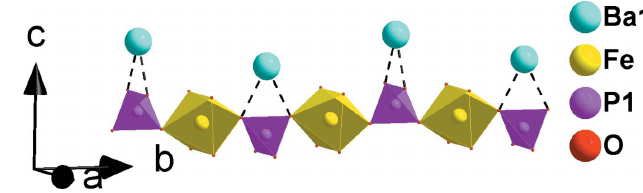
Figure 3 A chain formed by sharing corners of [FeO 6 ] octahedra and P1O 4